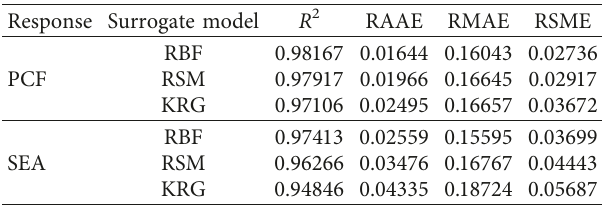
Figure 8: Sample points of design: (a) space view; (b) projected view. Table 1: Accuracy assessment of different surrogate